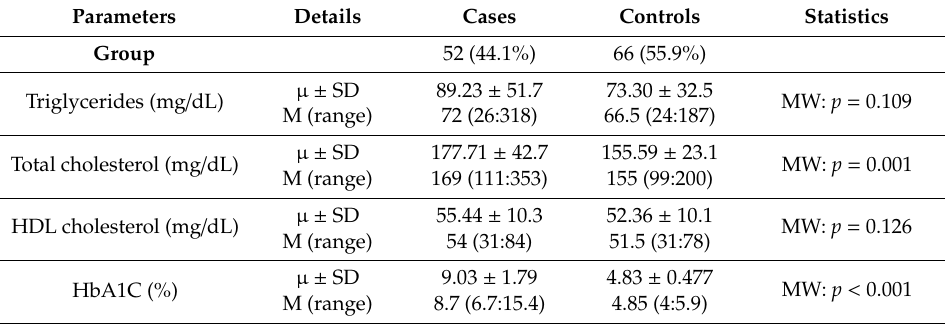
Table 3. Other laboratory values by groups.